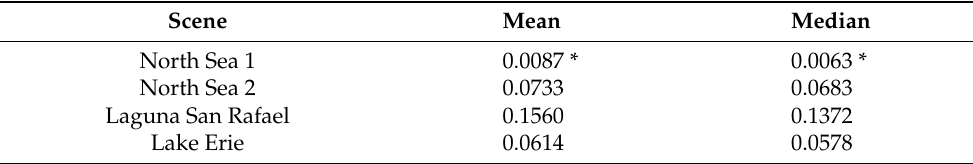
Figure 9. The mean quantization error as a function of sample size for PCA-initialized 32 ( black ), or SOMs trained with an update radii of 8 ( blue ), 2.7 ( red ), and 1 ( orange ) as evaluated on either the reduced sample size ( dotted ) or full image ( solid ). Table 5. Relative quantization error resulting from 64 Sea 1.